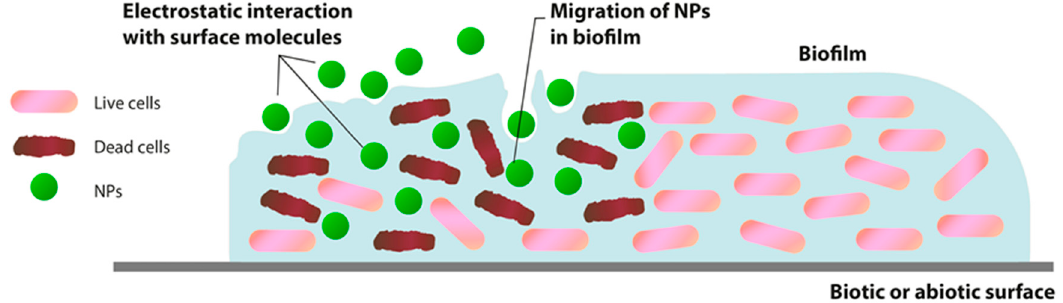
Figure 1. Interaction between metal oxides nanoparticles (NPs) and biofilm.